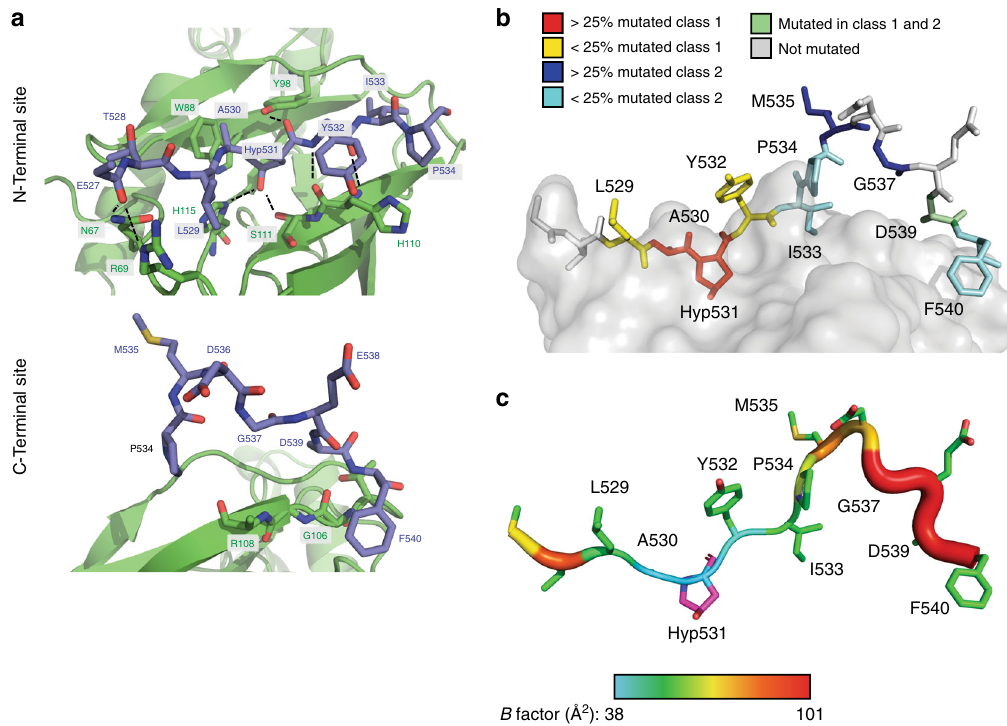
Fig. 3 Class 1 mutations impact residues important for pVHL af fi nity to HIF-2 α . a HIF-2 α is shown as a stick model and pVHL is modeled as a cartoon with key residues displayed as stick models. Carbon is shown in green (pVHL) or light blue (HIF-2 α ), oxygen is shown in red, nitrogen is shown in blue, and sulfur is shown in yellow. Hydrogen bonds are denoted by dashed lines. (top panel) Interaction of HIF-2 α residues 527-534 with pVHL. (bottom panel) Interaction of HIF-2 α residues 534 – 540 with pVHL. Backbone atoms for pVHL residues G106 and R108 are labeled. b The HIF-2 α peptide is shown as a stick model and the pVHL complex is displayed as a van der Waal surface (gray) set to 50% transparency. Mutations reported in HIF-2 α driven disease are color-coordinated according to mutation frequency. Residues not reported to be mutated are shown in gray. c The residues of the HIF-2 α peptide are colored according to temperature factor ( B factor). As the B factor increases, the color transitions from blue to red and the peptide backbone (modeled as a putty) increases in diameter. A high B factor is indicative of increased fl exibility and mobility. B factor values range from a low of 38.13 (Hyp531) and to a high of 100.28